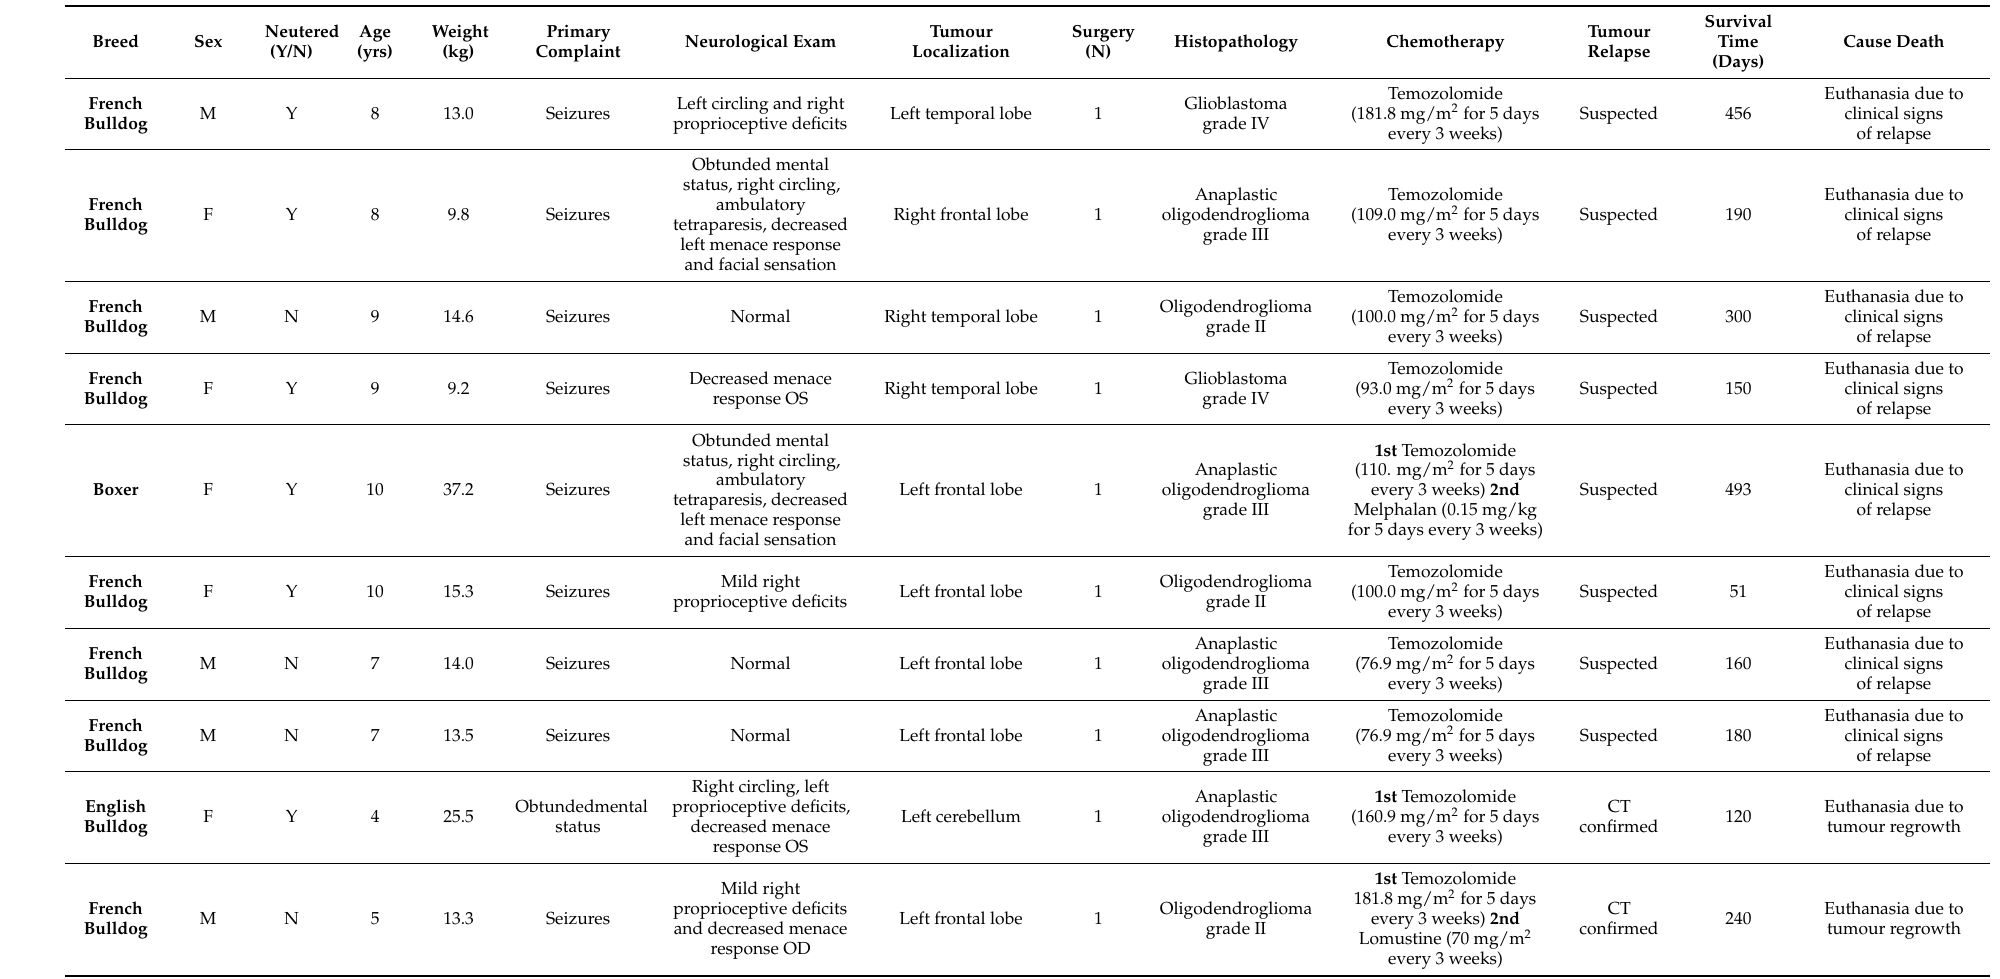
Table 1. Clinical data of dogs diagnosed with gliomas treated with surgery and